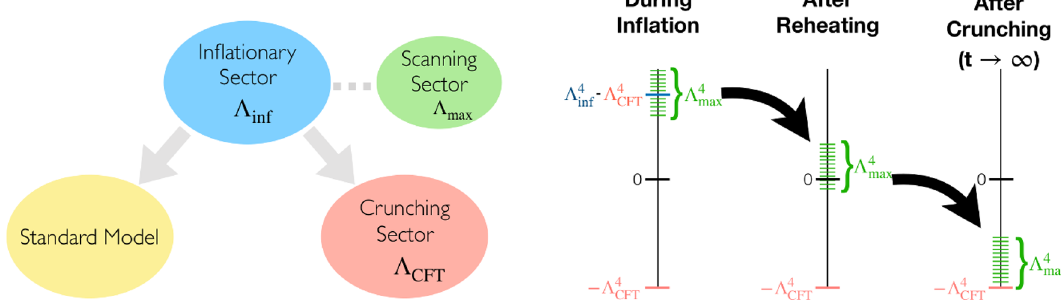
Figure 1 . Left: our model assumes three different sectors in addition to the SM. The inflationary sector is responsible for driving inflation at a scale Λ inf . Inflation need not be eternal or have a large number of e-folds (see section 7 for the discussion on a lower bound). The scanning sector may be independent of all other sectors and is responsible for producing a variety of Hubble patches with varying CC values. The crunching sector, which takes the focus in this paper, is responsible for the dynamics that drives each patch with a large CC, Λ 4 ≤ Λ 4 to crunch within a time of order max √ H − 1 ∼ (Λ 2 / 3 M Pl ) − 1 from the end of the inflationary period. In the scenario discussed below, Λ this sector is a CFT, spontaneously broken at low temperature with a vacuum energy − Λ 4 . CFT Right: the three scales are assumed to be (possibly very mildly) hierarchical: Λ max < Λ CFT < Λ inf . During inflation the crunching sector sits in the true vacuum and the inflaton dominates the energy density. A variety of Hubble patches with energy densities lying around the scale Λ 4 − Λ 4 and inf CFT with a range of order Λ 4 , are populated during this epoch. After reheating, the crunching sector max sits in the false vacuum and does not contribute to the CC. The patches’ energy densities are then distributed (possibly non-symmetrically) around zero with the same range of order Λ 4 . Those max with large negative cosmological constant will crunch independently of the crunching sector while those with positive (or small negative) crunch only once the CFT phase transition is completed, thereby reducing their energy density by Λ 4 and driving it to negative values. Eventually, at CFT late times, all patches go through the phase transition and